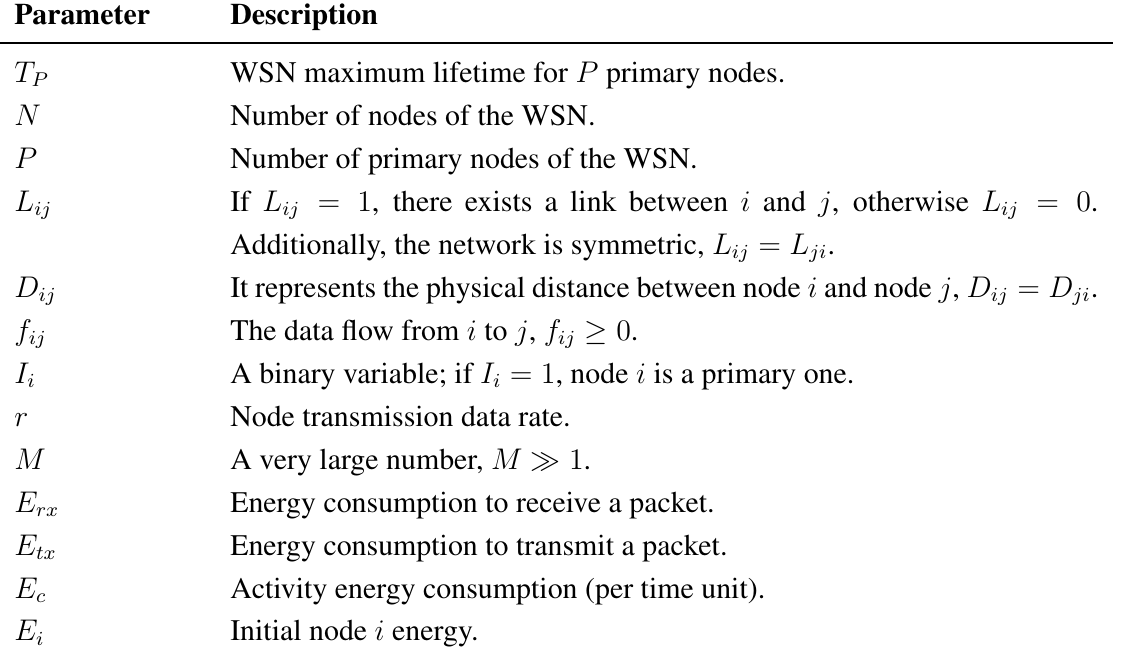
Table 2. Primary node assignment problem